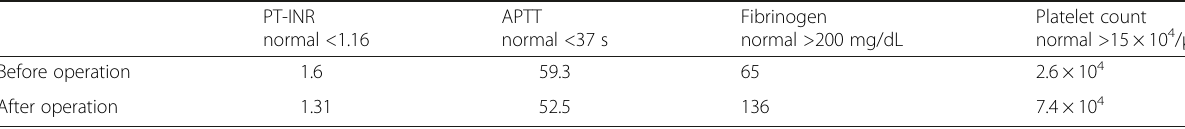
Table 1 Change in data obtained by conventional tests during the operation PT-INR normal <1.16